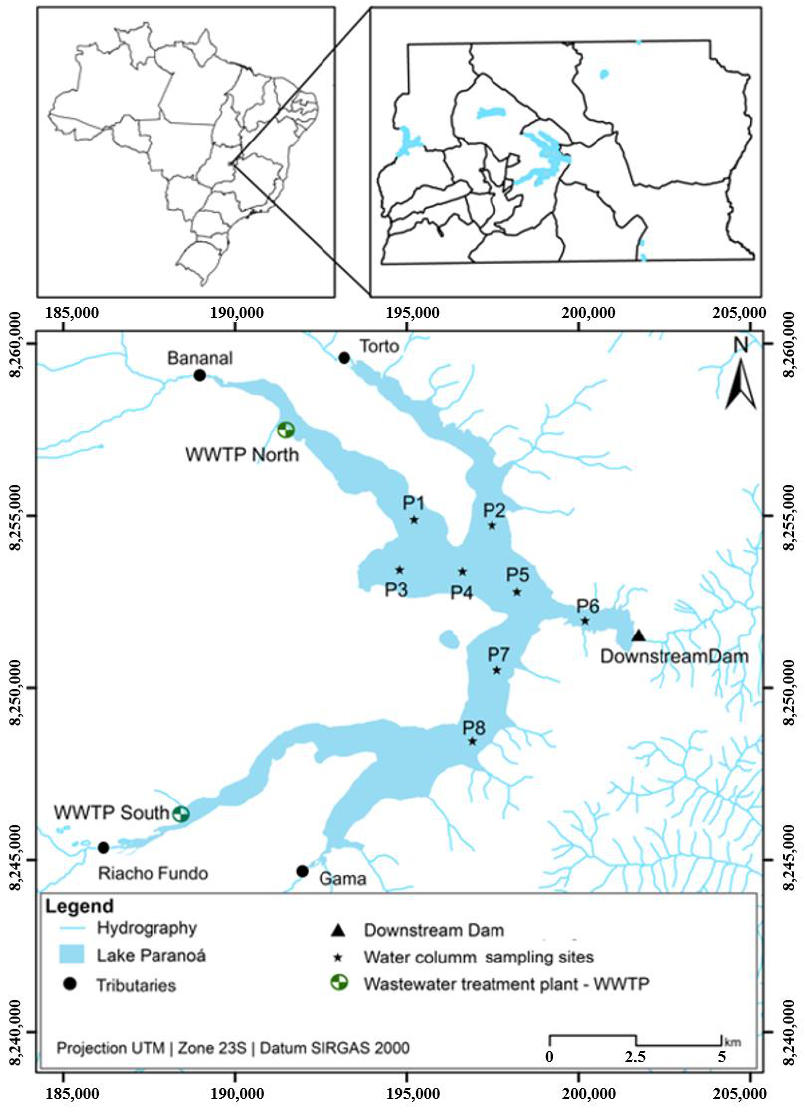
Figure 1. Study area and sampling sites in the Lake Paranoá. The catchment area is 1034 km 2 and there are four main tributaries that discharge into Lake Paranoá: the Riacho Fundo and Gama streams at the south and the Bananal and Torto streams at the north.